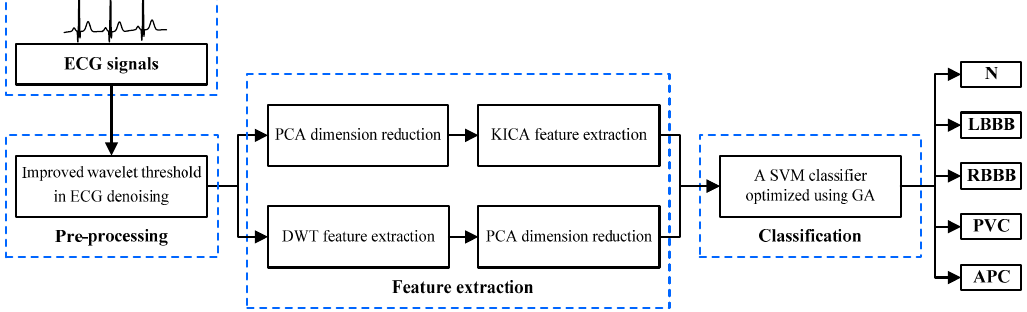
Figure 1. Block scheme of the proposed electrocardiogram (ECG) recognition system for ECG beats classification. The presented system is composed of ECG pre-processing, feature extraction and classification. ECG pre-processing removes noise and interference from original ECG beats. Feature extraction derives multi-domain features through kernel-independent component analysis (KICA) and discrete wavelet transform (DWT). The support vector machine (SVM) classifier, optimized with genetic algorithm (GA), divides ECG beats into five categories: normal beat (N), left bundle branch block beat (LBBB), right bundle branch block beat (RBBB), premature ventricular contraction (PVC) and atrial premature beat (APC).